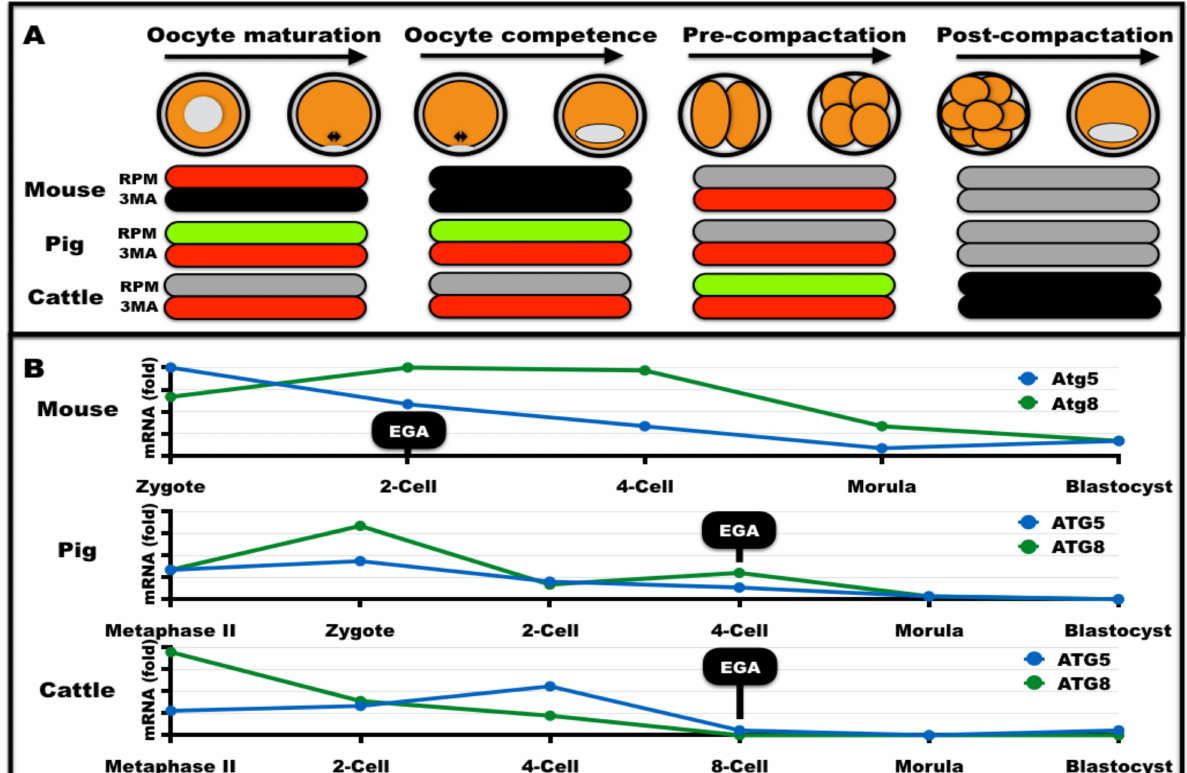
Figure 2. Autophagy modulation on mammalian oogenesis and preimplantation embryonic development. ( A ) In vitro incubation of oocytes/embryos with rapamycin (RPM; mTOR inhibitor/autophagy inducer) or 3-methyladenine (3MA; Type III PI3K inhibitor/autophagy inhibitor). Green bar: stage-specific improvement in oocyte maturation (progression from germinal vesicle to metaphase II stage), oocyte competence (ability of an oocyte to give rise to a blastocyst), and preimplantation embryonic developmental potential at the pre-compactation (zygote to 4-cell) and post-compactation (beyond 4-cell) stages (increase in cleavage and blastocyst yields, respectively). Red bar: stage-specific decrease in oocyte maturation, oocyte competence, or embryonic developmental potential. Gray Bar: no observable effect. Black bar: not determined. ( B ) Schematic representation of mRNA levels for the autophagy genes autophagy-related protein 5 (ATG5) and autophagy-related protein 8 (ATG8/LC3) during preimplantation embryonic development in selected mammalian species. Black boxes highlight the embryonic genome activation (EGA) for each species (the EGA in cattle occurs in the eight-to-sixteen cell stage